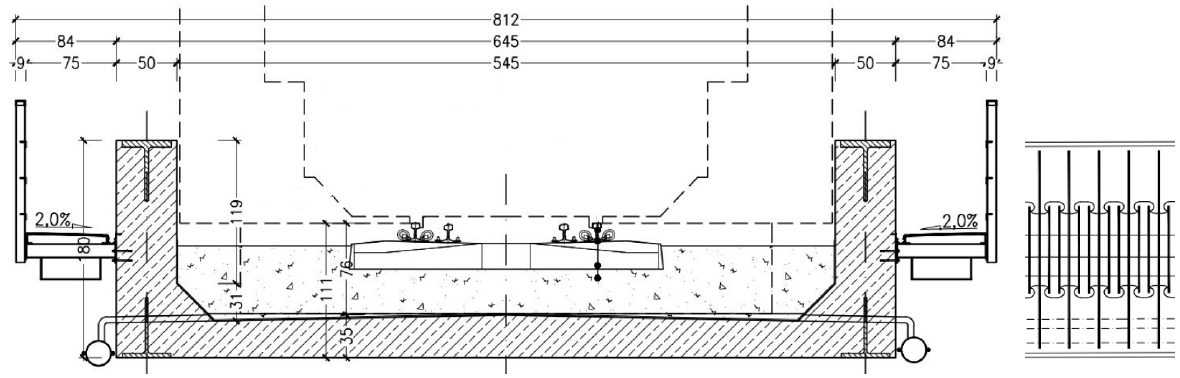
Figure 7: Cross section of one of the bridges along the S3 road being designed currently by Europrojekt Gdańsk.